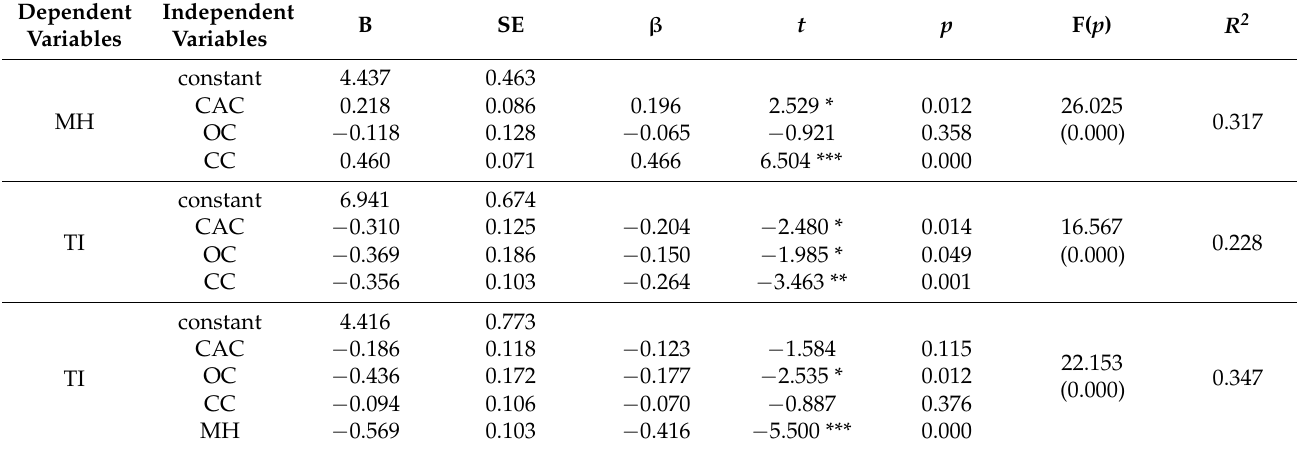
Table 4. Effects of cross-cultural competency, occupational competency, and coping competency on mental health and turnover intention, and the mediating effect of mental